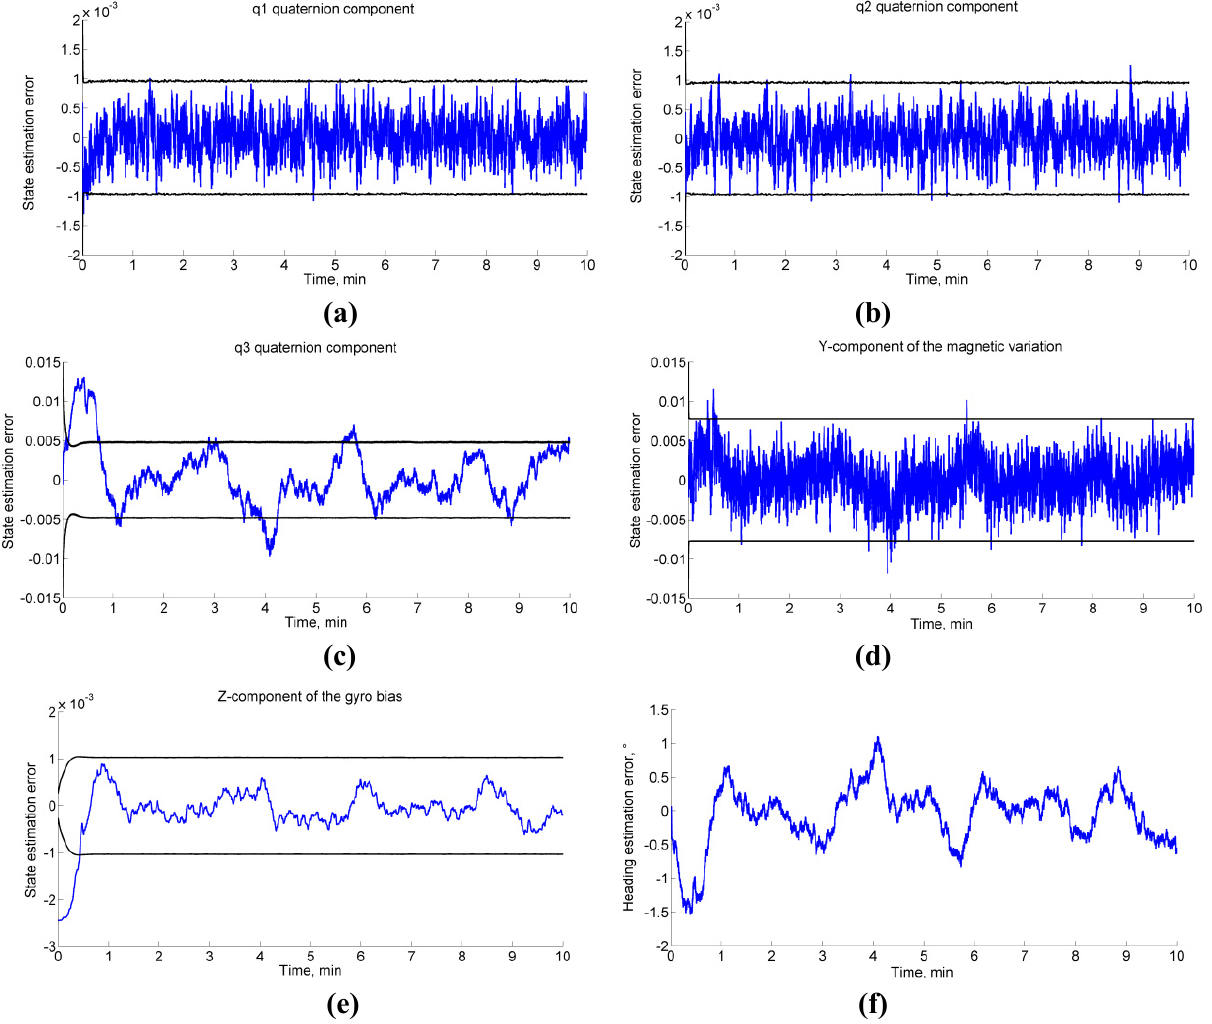
Figure 1. (a)–(e) State errors from the EKF. (f) Heading estimation error. (a)–(c) , q , q . (d) Magnetic variation Y -component. (e) Gyro bias Quaternion components q 1 2 3 Z -component. The black lines show the 3 standard deviation bounds estimated by the